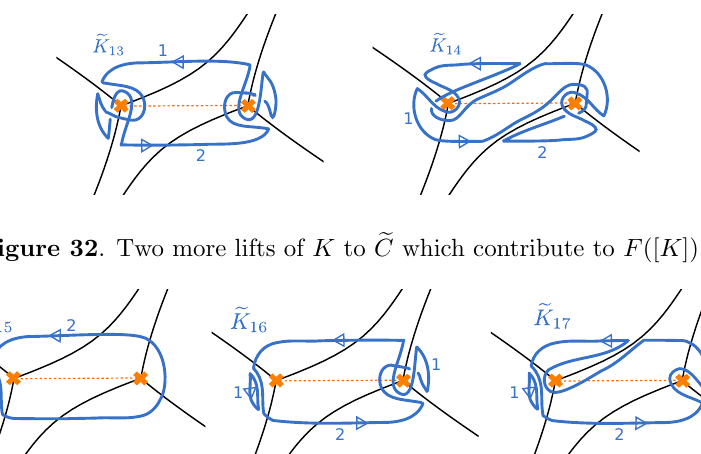
Figure 31 . Two more lifts of K to e C which contribute to F ([ K ]).